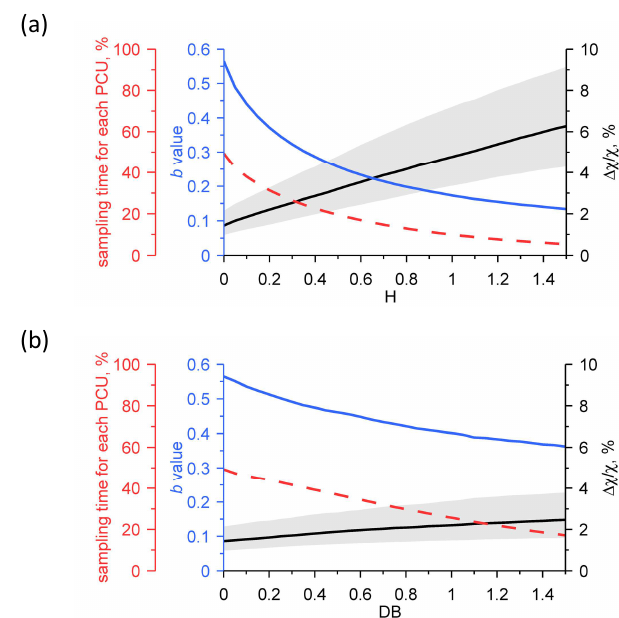
Figure 3: Effect of various dead band sizes on the expected relative PAN mixing ratio differences, the 1 Figure 3. Effect of various dead band sizes on the expected rel- ative PAN mixing ratio differences, the b value and the sampling the sampling time for the application of the REA method. Median values are displayed 2 (cid:7) -value and time for the application of the REA method. Median values are dis- played and the shaded area represents the interquartile range of the and the shaded area represents the interquartile range of the expected mixing ratio differences. 3 expected mixing ratio differences. Variations of the b value and the sampling time were only small. Shown are the results from the sim- Variations of the (cid:7) -value and the sampling time were only small. Shown are the results from the 4 ulation based on data from the Mainz-Finthen grassland site for the simulation based on data from the Mainz-Finthen grassland site for the period from 1 August to 5 period from 1 August to 30 September 2011 employing (a) a hyper- bolic dead band with O 3 as a proxy scalar and (b) a fixed dead band 30 September 2011 employing (a) a hyperbolic dead band with O value scaled by σ w dead band value scaled by (cid:8) only. 7 (cid:9)